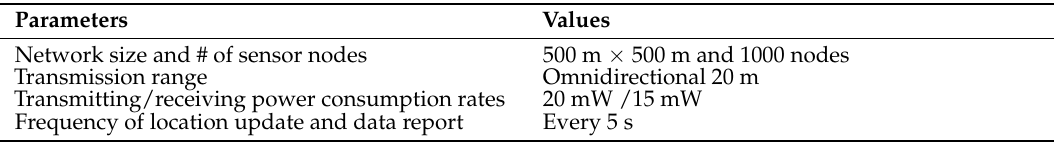
Table 2. Default simulation environment settings.